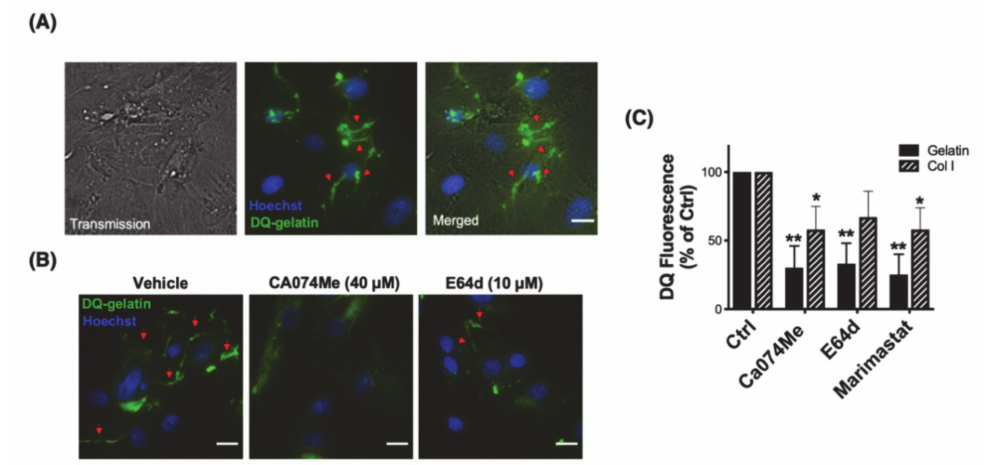
Figure 2. CTSB mediates pericellular proteolysis in hTM cells. ( A ) Representative image of pericel- lular proteolysis in hTM cells. Proteolytic degradation products of DQ-gelatin (green fluorescence) were monitored as described in materials and methods. ( B ) Representative image of pericellular pro- teolysis in hTM cells in the presence of the CTSB or cysteine cathepsin inhibitors Ca074Me and E64d, respectively. ( C ) Flow cytometry quantification of DQ-gelatin and DQ-Col I proteolytic degradation products in the presence and absence of Ca074Me, E64d, or marimastat (MMP inhibitor). Data are shown as the mean ± S.D. * p < 0.05; ** p < 0.01, n = 3. Hoechst (blue fluorescence) was used to stain nuclei. Red arrows represent the pericellular degradation of DQ-gelatin. Scale bars: 20 µ